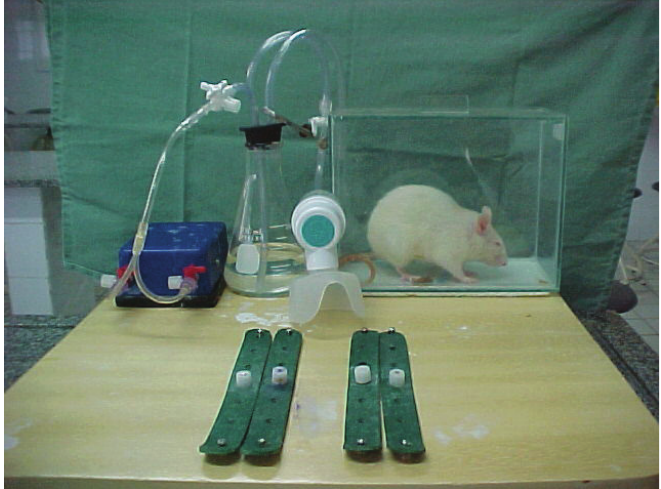
FIGURE 2 - Anesthetic equipment in use, with a rat in the induction chamber and the pediatric inhalation